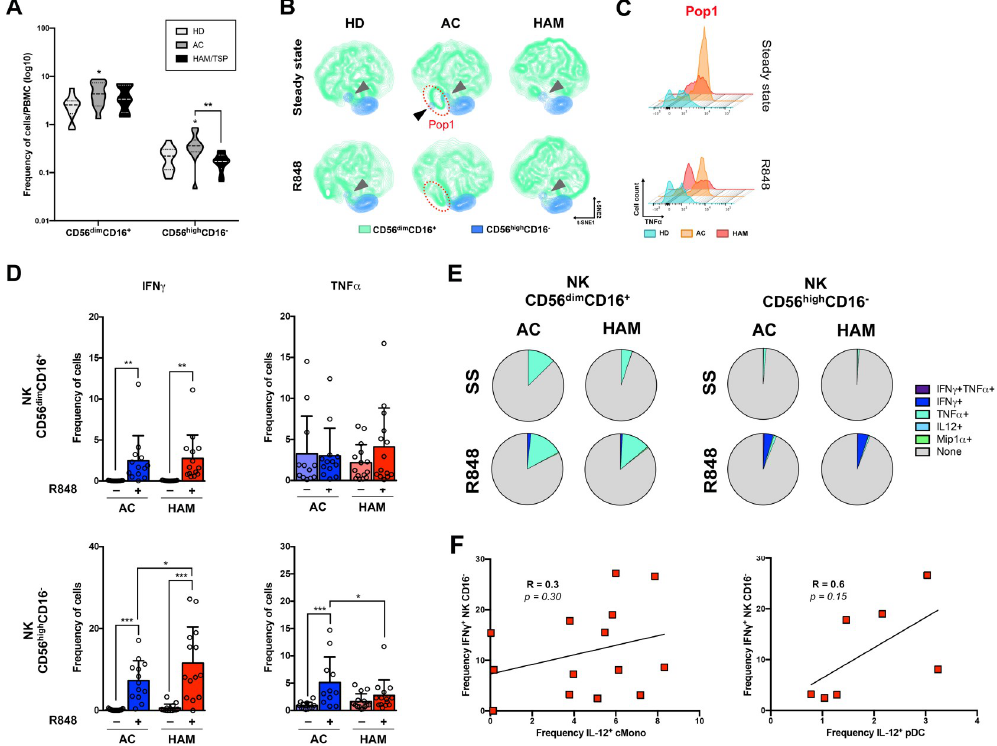
Fig 4. NK cells from HAM/TSP present greater response to IFN γ after stimulation. (A) Violing-plot representation of the cell frequency of NK subpopulations in the 3 clinical groups. (B) t-SNE clustering of the NK cells reveals different subpopulations and (C) the histogram represents TNF α expression of the identified population (Pop1). (D) Bar-plot representing the frequency of cytokine producing cells by the gated NK subpopulations at steady state and upon R848 stimulation. (E) Boolean analysis of the multiple-cytokine production by the NK subtypes at steady state (NS) and after TLR7/8 stimulation (R848). (F) Correlation between the frequency of IFN γ + NK CD16 + and the frequency of IL-12 + classical monocytes (left) or pDC (right) after